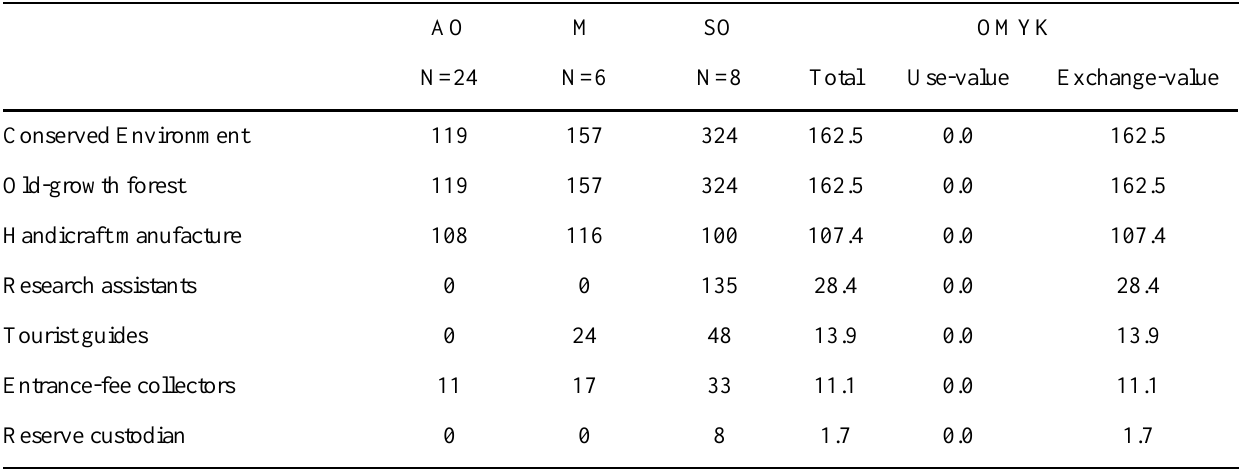
Table 5. Activities and average annual labor allocation by households’ productive strategy and OMYK as a whole in the Conserved Environment (CET). Numbers are per household and based on an 8-hour work